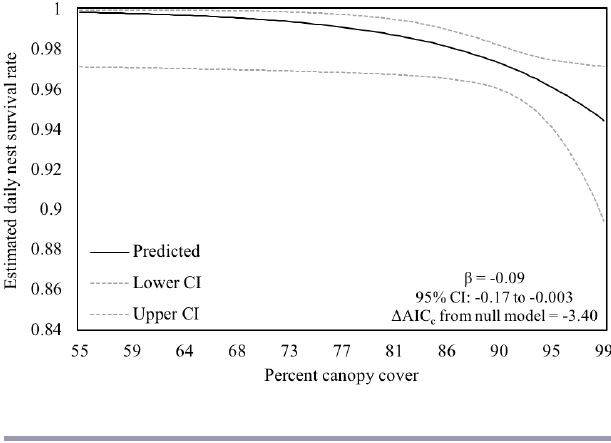
Fig. 4 . A negative relationship between canopy cover (within 5 m of the nest tree) and daily nest survival existed for Prothonotary Warblers ( Protonotaria citrea ) nesting in White River National Wildlife Refuge, Arkansas, USA in 2014–2015. This relationship was estimated based on a nest survival model that included percent canopy